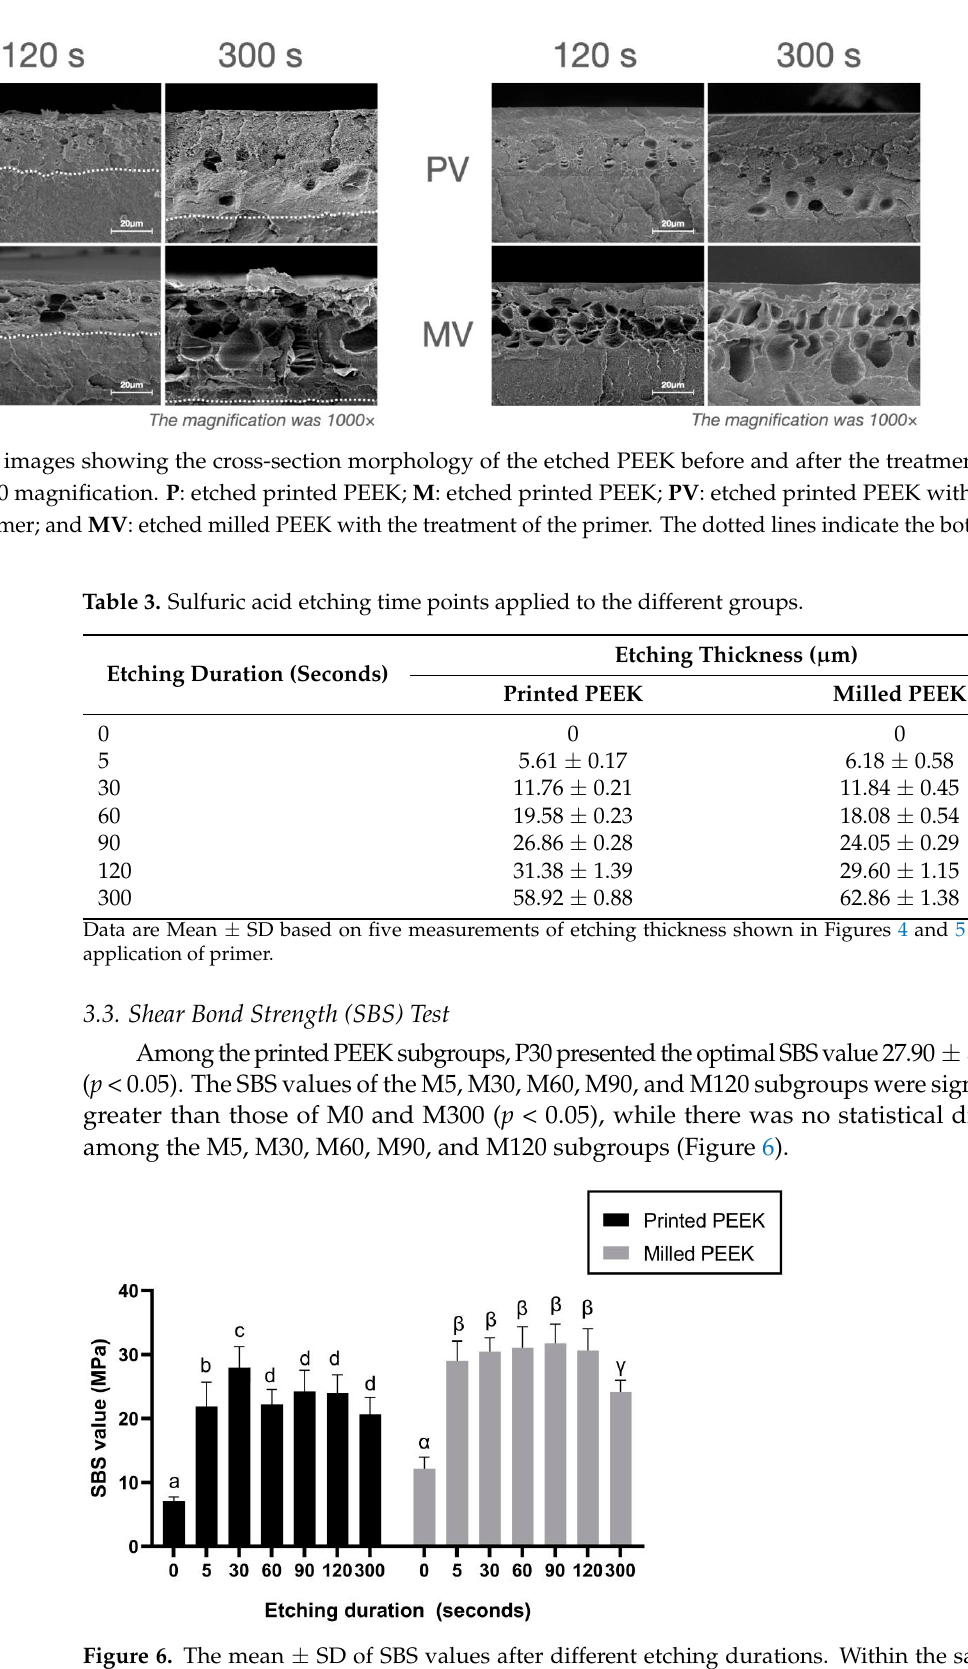
Figure 4. The SEM images showing the cross-section morphology of the etched PEEK before and after the treatment of the bonding primer at ×2500 magnification. P : etched printed PEEK; M : etched printed PEEK; PV : etched printed PEEK with the treatment of the primer Visio.link; and MV : etched milled PEEK with the treatment of the primer Visio.link. The dotted lines indicate the bottom of the etched pores. For overall views of the etched pores of the groups (etching duration 120 s and 300 s), the SEM images (×1000 magnification) were further supplied in Figure 5.